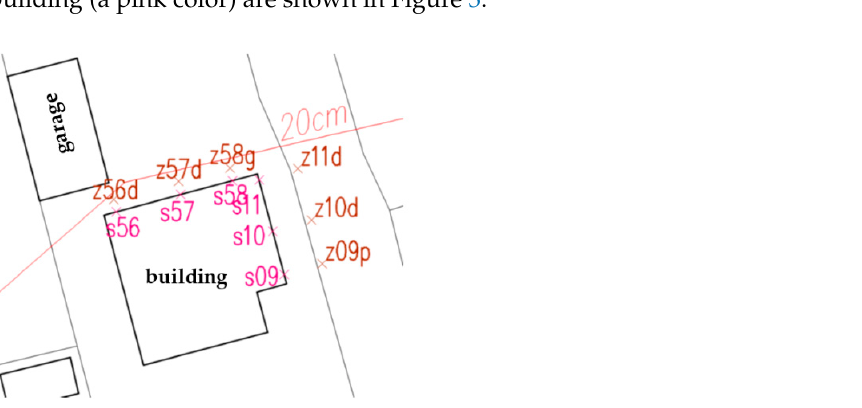
Figure 2. A residential building: ( a ) on the background of the longwall’s contours in the 404/3 seam – pink line, the 404/5 seam – green line and the 405/1 seam – orange line (yellow circle); ( b ) a view from north-eastern side.